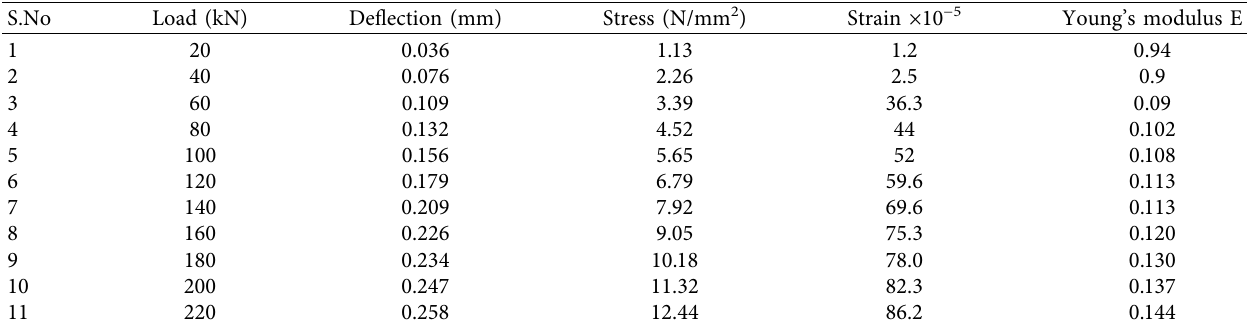
Figure 10: (a) Arrangement of experimental set. (b) Testing of GFRP-wrapped columns in compression testing machine. Table 4: Young’s modulus for M20 grade of the column with 0mm wrapping.